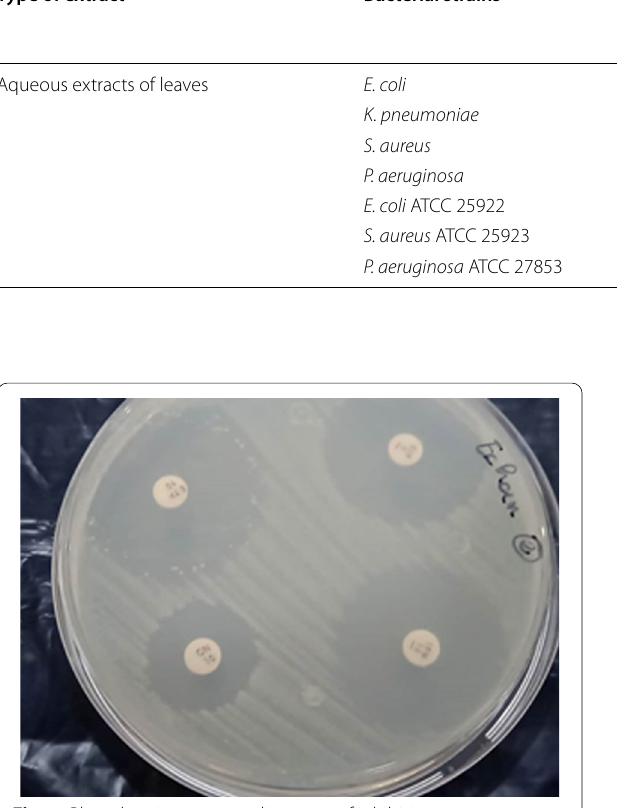
Table 6 Average diameters of inhibition zones Type of extract